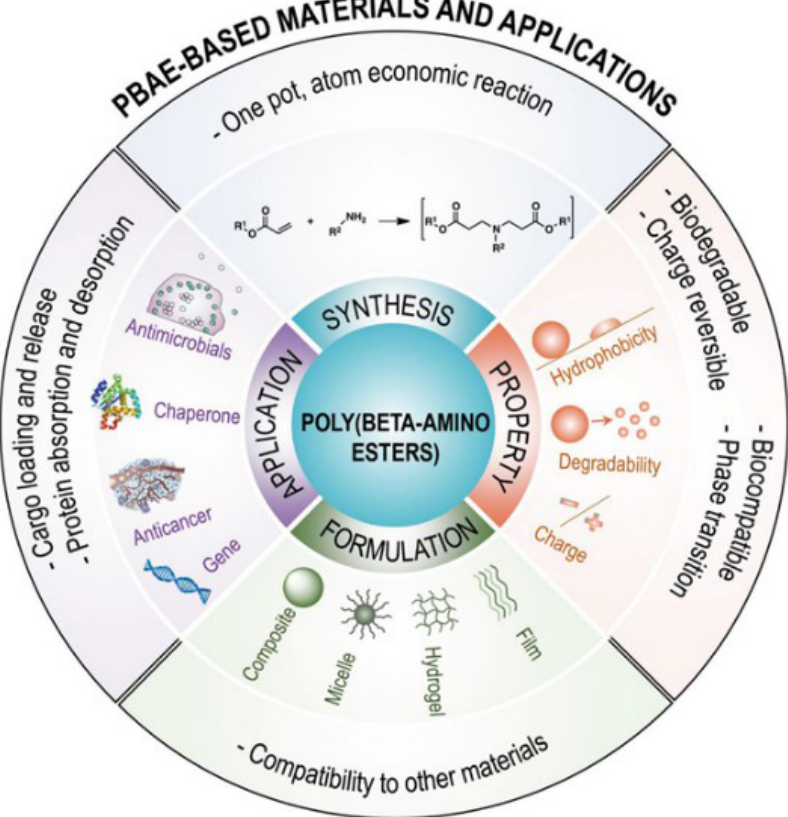
Figure 1. The properties of PAEs and PAE-based materials. Reproduced by permission of Copyright © 2018 WILEY-VCH Verlag GmbH & Co. KGaA, Weinheimfrom Ref. [86]. Poly( β -amino esters) (PBAE) are synthesized via a one-pot, atom-economic Michael addition of amines (NH 2 -R 2 ) to acrylates (CH 2 =CHCOOR 1 ) without the production of any side products.